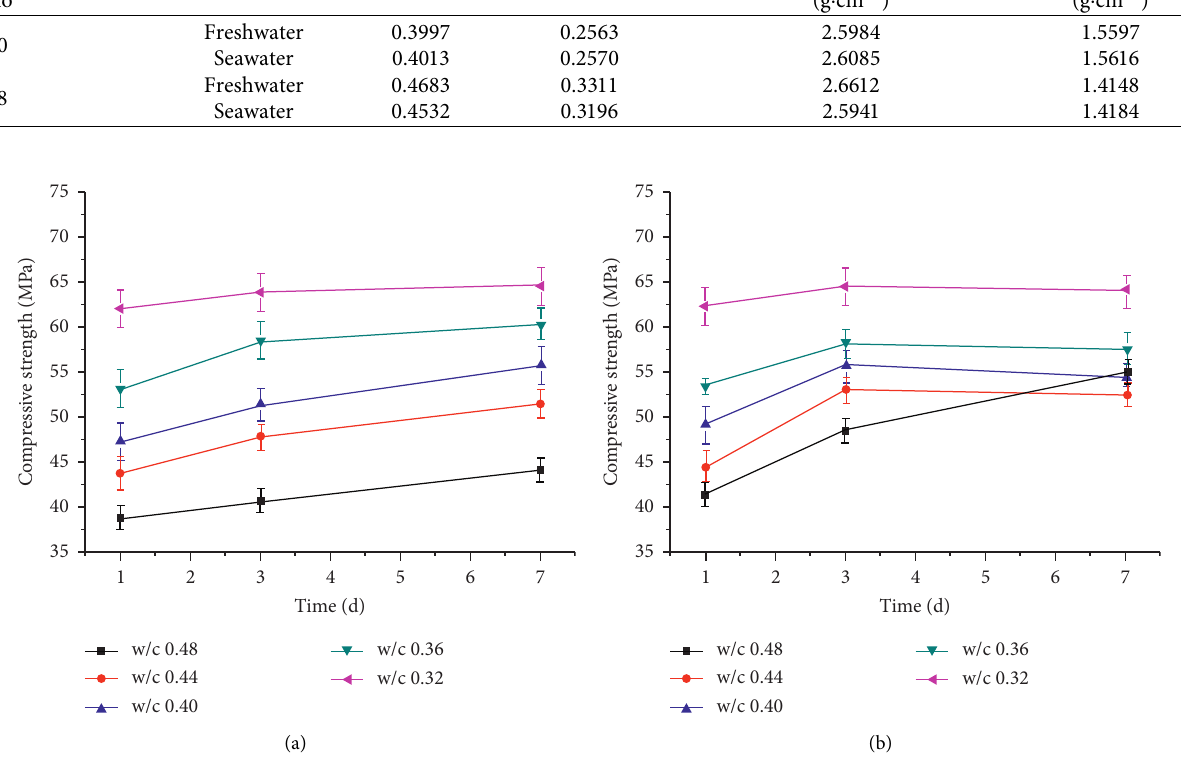
Figure 5: The influence of w/c ratio on the compressive strength of CSA cement. (a) Freshwater. (b) Seawater.